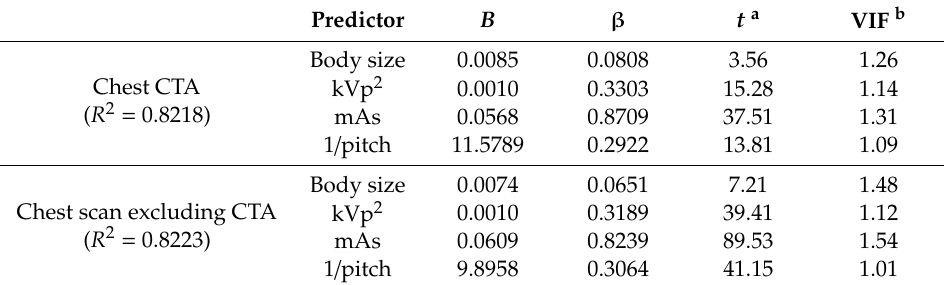
Table 5. Results of multivariate analysis for the chest scans performed using MDCT 64 .